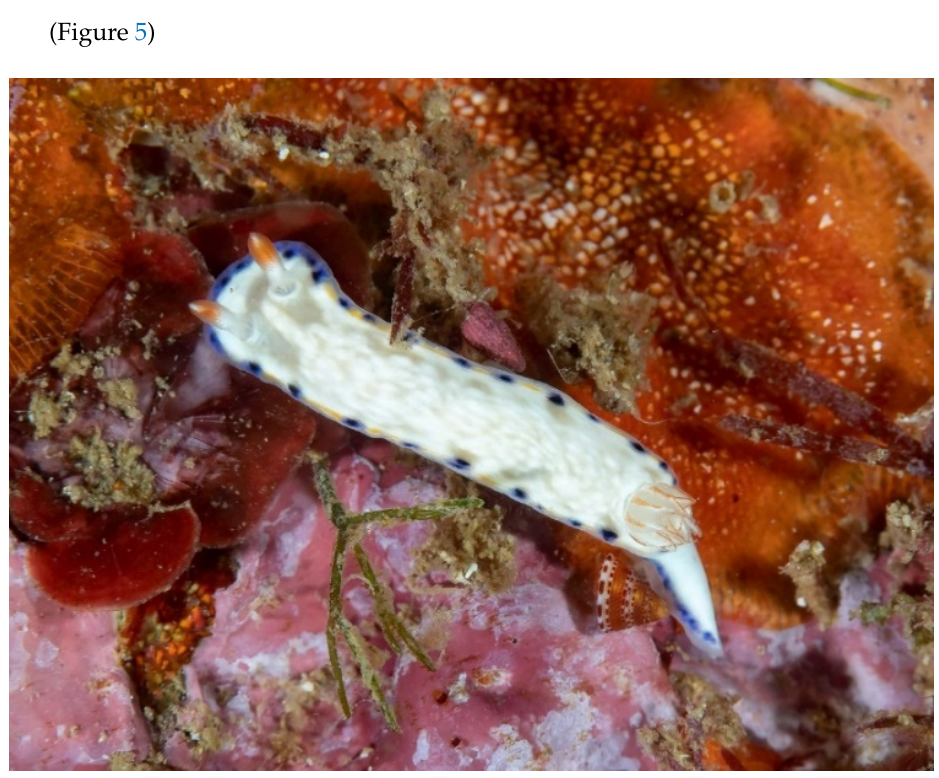
Figure 5. Hypselodoris sagamiensis , South Solitary Island, NSW, 25 January 2022. Photo: C. Lewis.